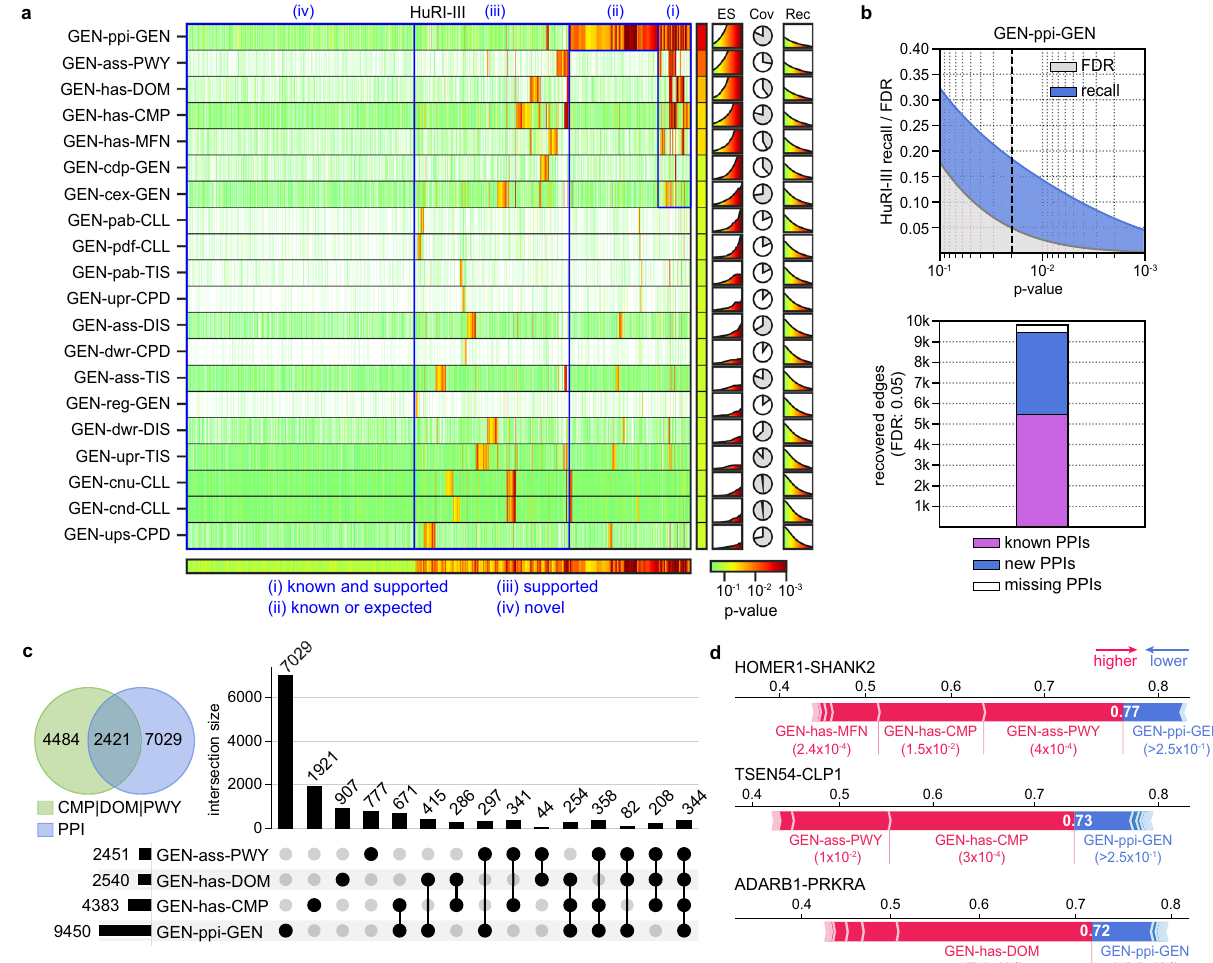
Fig.6 |AssessingthenoveltyoftheHuRI-IIIinteractome.a Embeddingdistance P values are calculated for each PPI in HuRI-III (x-axis) using the corresponding gene-gene (GEN – GEN) embeddings from a subset of metapaths (y-axis). Please, note that these P values do not re fl ect the signi fi cance of any statistical test, but indicate the normalized quantile rank position of a given observation in a back- ground distance distribution ( “ Methods ” ). Red tones (lower P values) indicate similarity according to a given embedding space. The column and row next to the heatmapshowthe10thpercentileofthe P valuedistributionforeachmetapathand thelowest P valueforeachedge,respectively.Inblue,wegroupededgesaccording to four levels of support. On the right, it is shown the enrichment scores (ES) (cappedbetween1and5onthey-axis)across P values,thecoverage(Cov),andthe cumulative recall (Rec) across P values. b (Top) Recovery of HuRI-III edges (recall) and randomly permuted edges (FDR) by ‘ protein interacts protein ’ (GEN-ppi-GEN) embeddings across the P values (x-axis). The dashed line is placed at the 0.05 FDR (corresponding to a P value of 0.02). (Bottom) Number of HuRI-III interactions